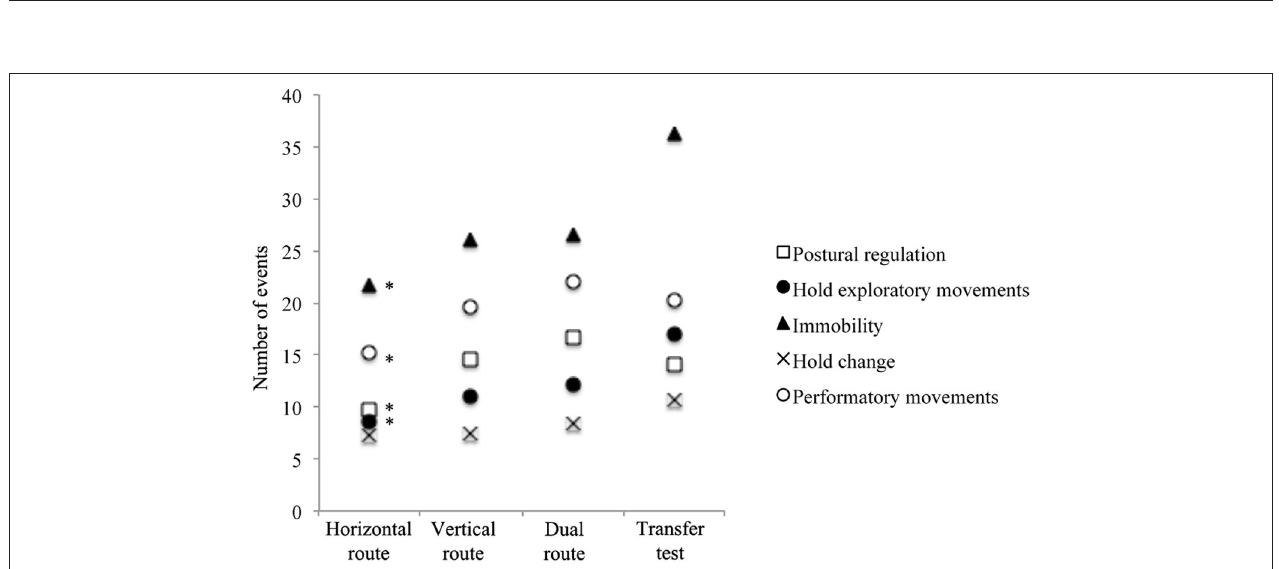
FIGURE 5 | Differences between the transfer test and the three routes performed during the learning protocol concerning the number of events of each of the five climbing states. *Simple contrast tests showing significant differences between the transfer test and the fourth session of each route.